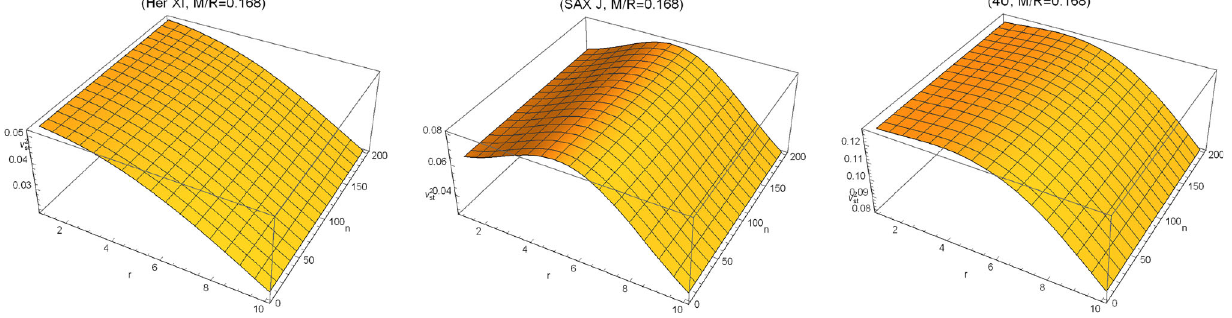
Fig. 12 Behavior of υ 2 r (km) and model parameter n in different compact stars st with radial coordinate